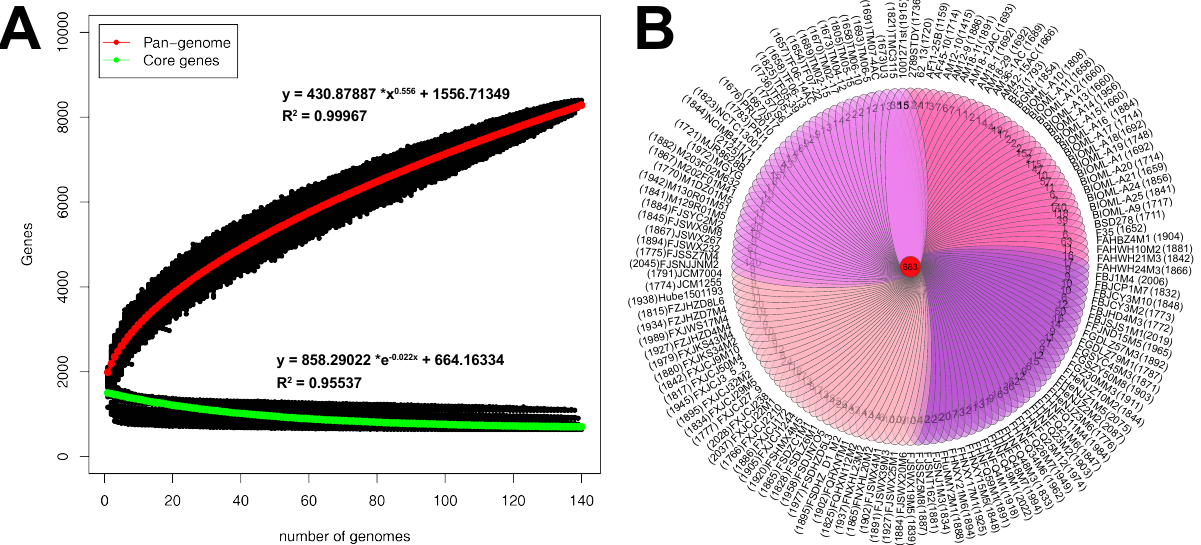
Figure 2. Pan-genome and core genes of 140 B. bifidum genomes ( A ). The 683 core genes and unique genes among B. bifidum genomes ( B